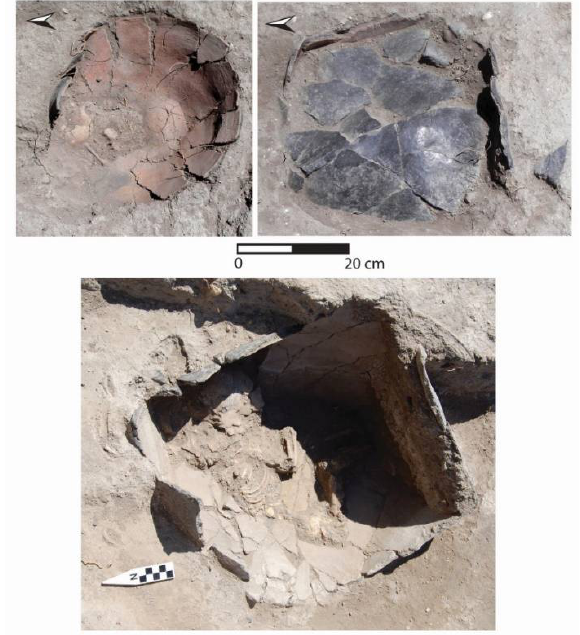
Figure 6. Photos of burials inserted into architectural features in the Agglutinated phase. Upper left and right (F134 and F136, respectively) are under a courtyard floor; bottom (F164) is a burial within the corner of a wall.